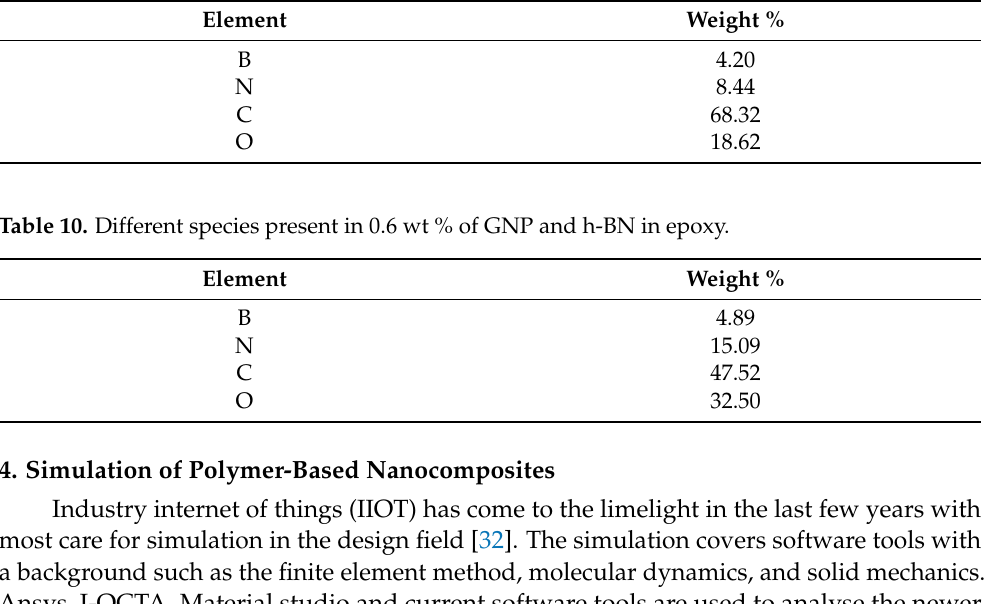
Table 9. Different species present in 0.4 wt % of h-BN in epoxy. Element